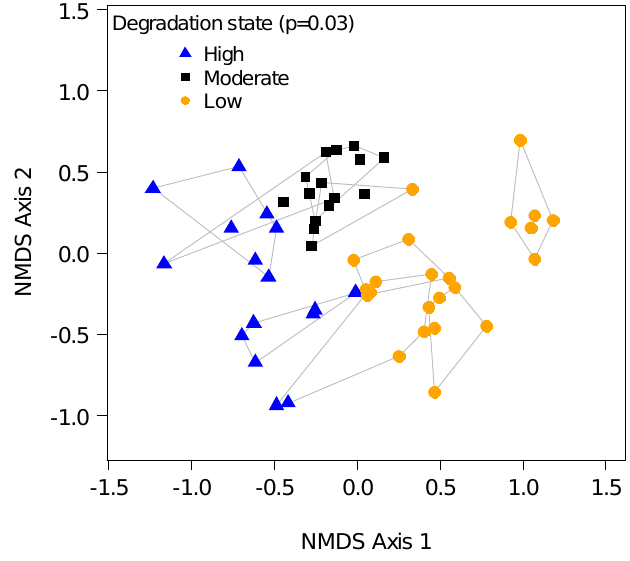
Figure 4. Ordination of plant species composition from 54 modified Whittaker plots (plots) by Nonmetric Multi-Dimensional Scaling (NMDS) of Canberra distances (k = 4, stress ≈ 12%). Plant communities plotted by floristic degradation state. Grey convex hulls connect tracts and correspond to same labels as in Figure 1. Groups significantly different in adonis test for dissimilarity ( p = 0.03).